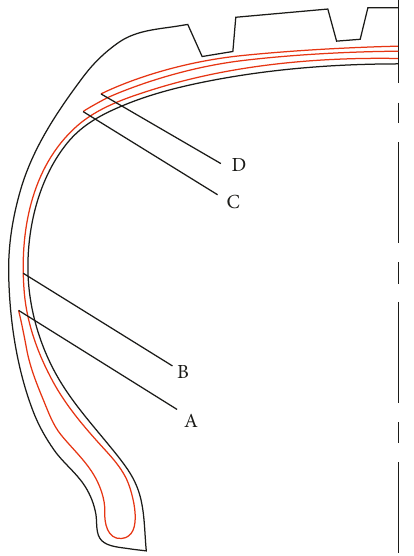
Figure 10: Points of circumferential analysis on